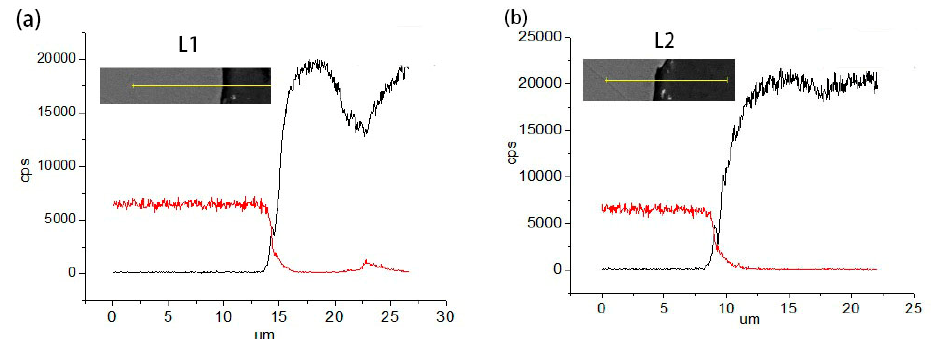
Figure 6. Linear energy spectra of the main elements of the welding interface in two different areas ( a ) area of L1; ( b ) area of L2.